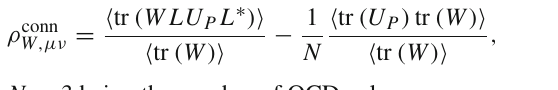
Subtracting E C from the simulated field E gives the ‘non- perturbative’ longitudinal field E NP pointing along the q ¯